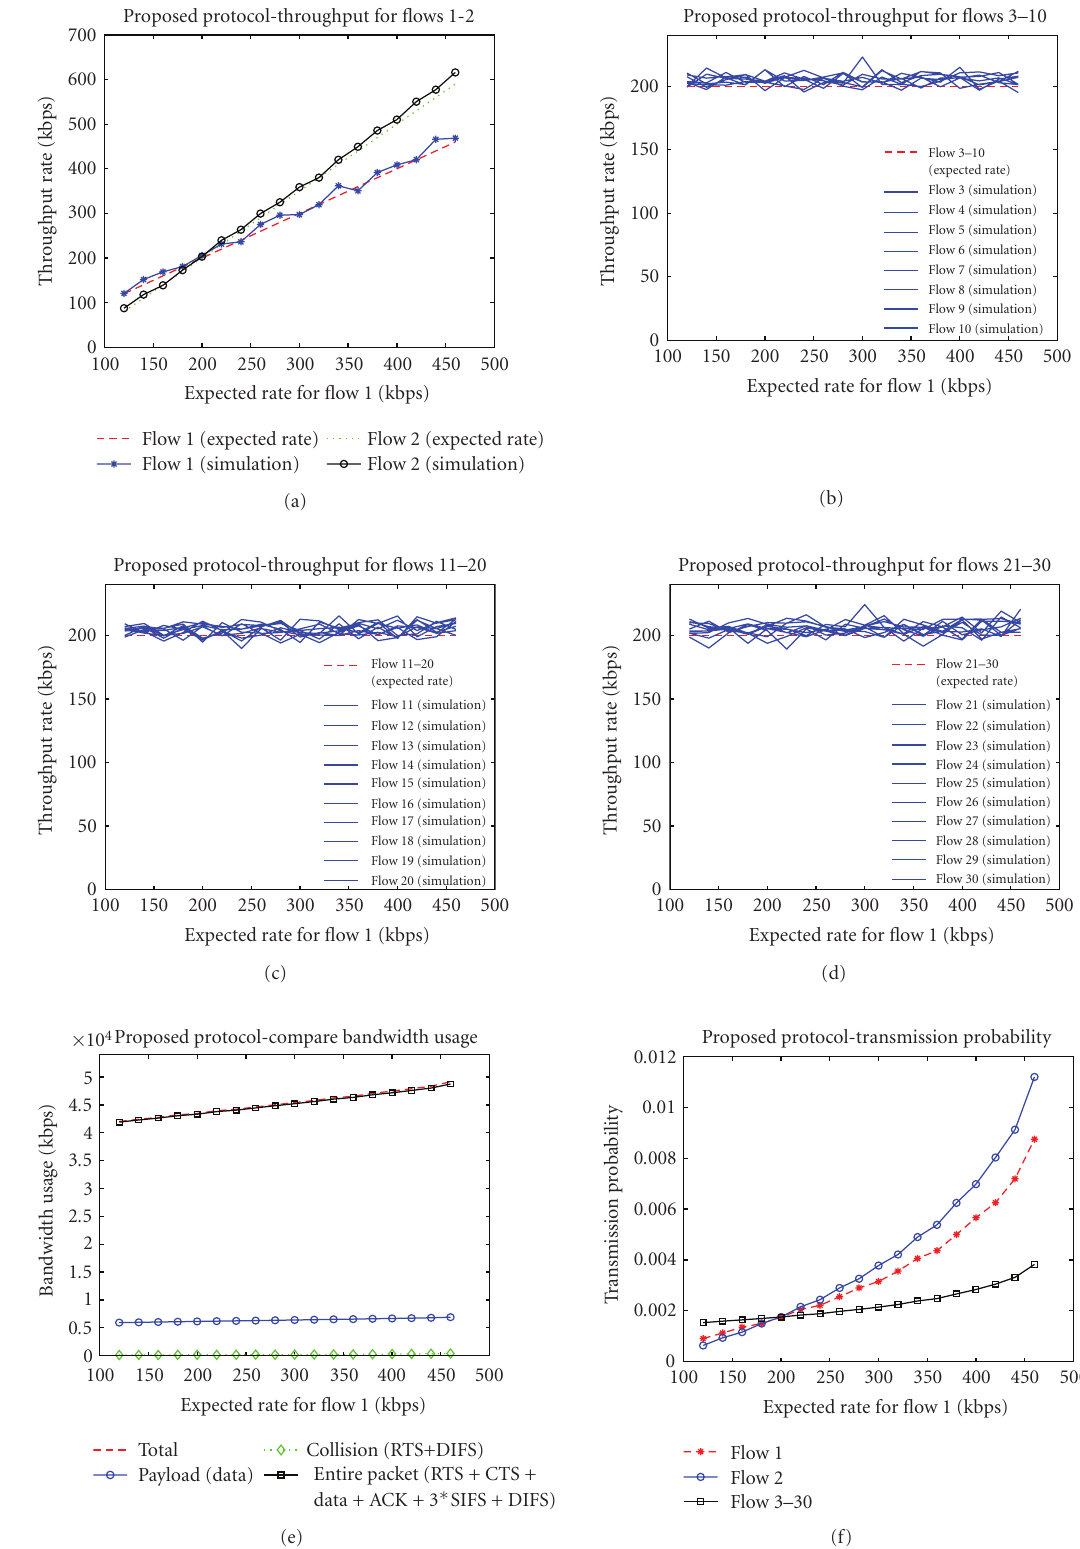
Figure 3: Proposed protocol validation with 30 flows over 54 Mbps bandwidth. (a) Throughput for flows 1 and 2, (b) throughput for flows 3–10, (c) throughput for flows 11–20, (d) throughput for flows 21–30, (e) overall bandwidth usage, (f) transmission